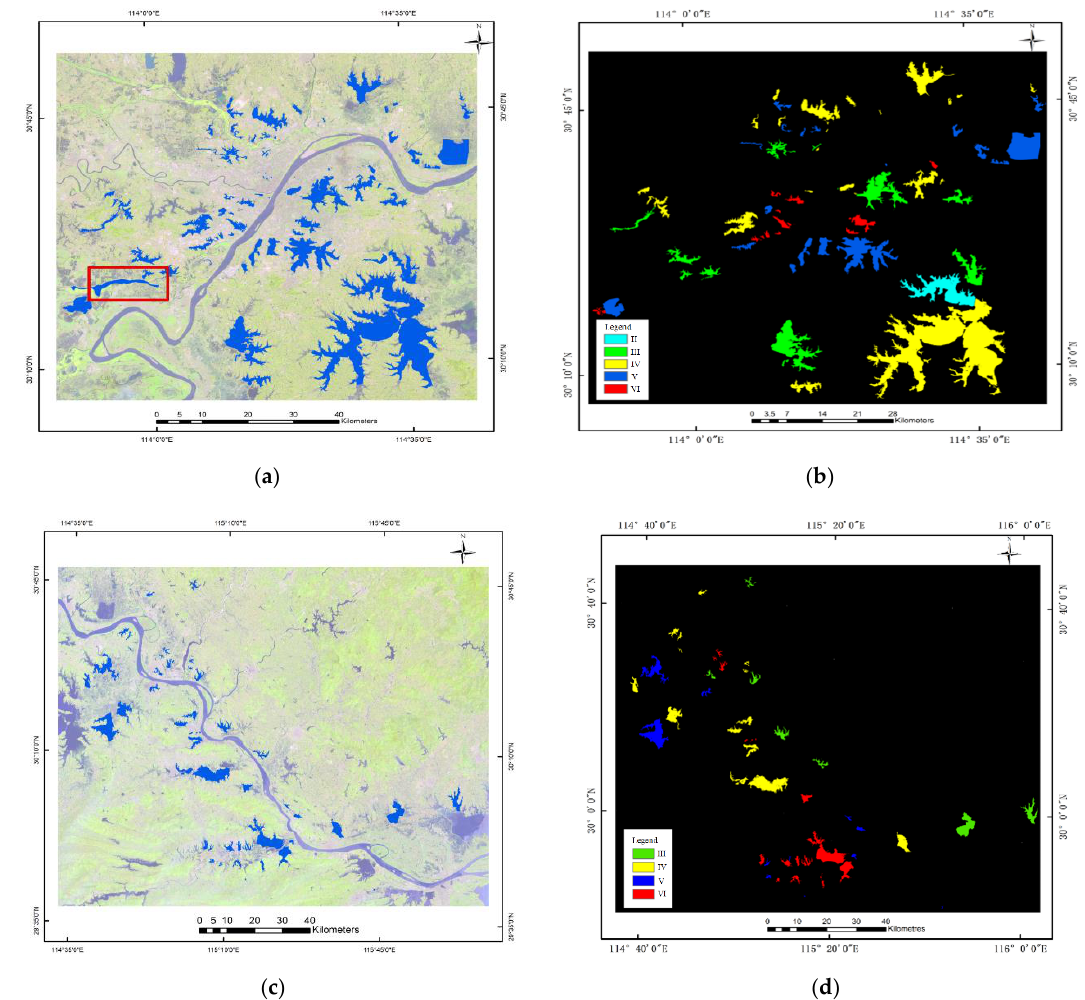
Figure 3. The datasets of the two study areas. ( a ) False-color composite and water vector data for the Wuhan study area. ( b ) ground-truth map in the Wuhan study area. ( c ) False-color composite and water vector data for the Huangshi study area. ( d ) ground-truth map in the Huangshi study area.